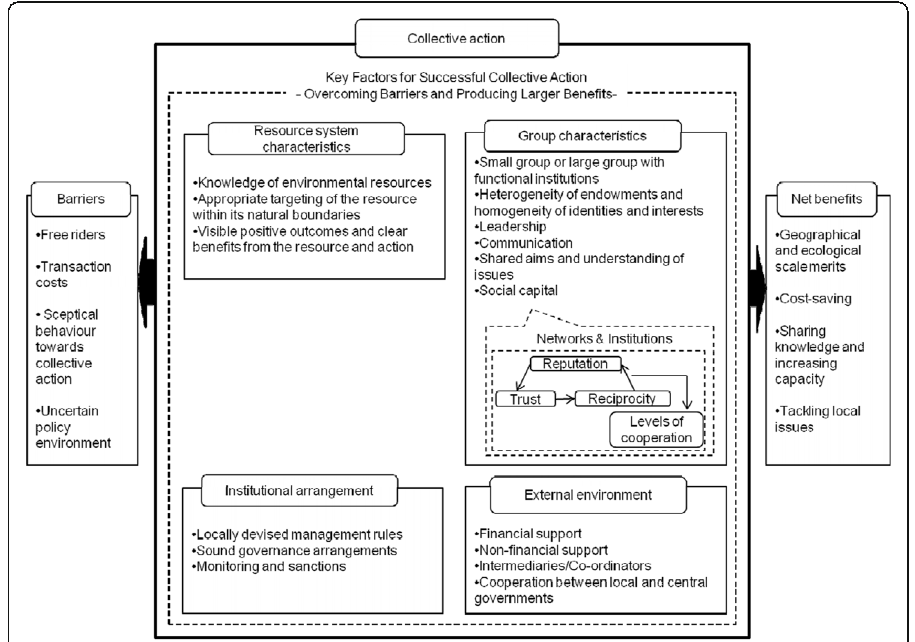
Fig. 1 Benefits, barriers, and key factors of collective actions. Source: OECD